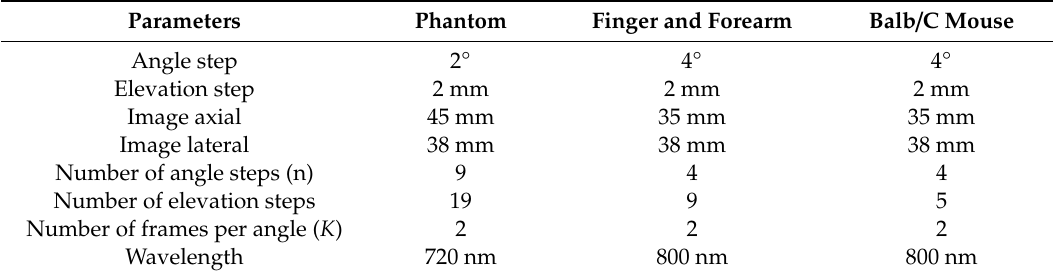
Table 1. Multiangle illumination and acquisition